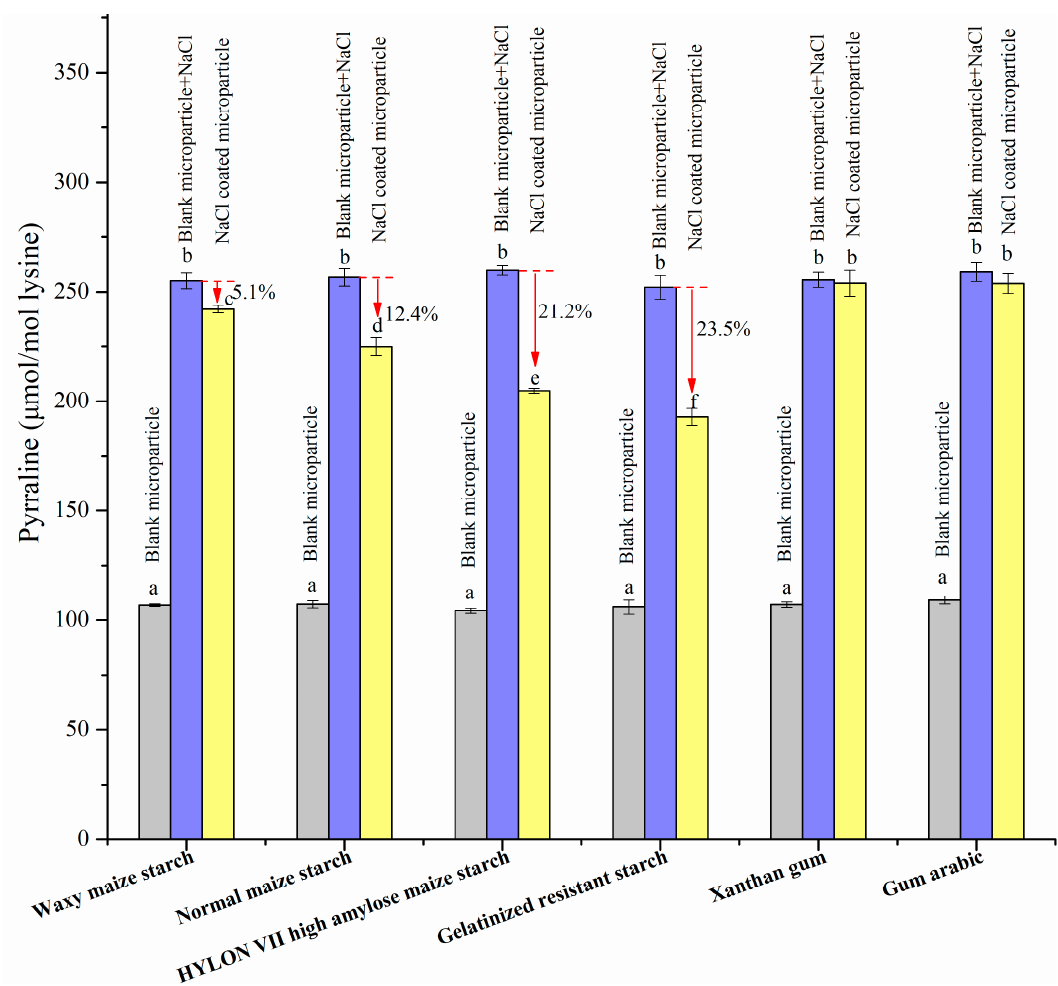
Figure 7. Concentration of pyrraline ( μ mol/mol lysine) in model systems prepared with different formulations (refer to Table 1 for the formulations). Values with the same letter within a column are not significantly different ( p > 0.05, Duncan’s test).